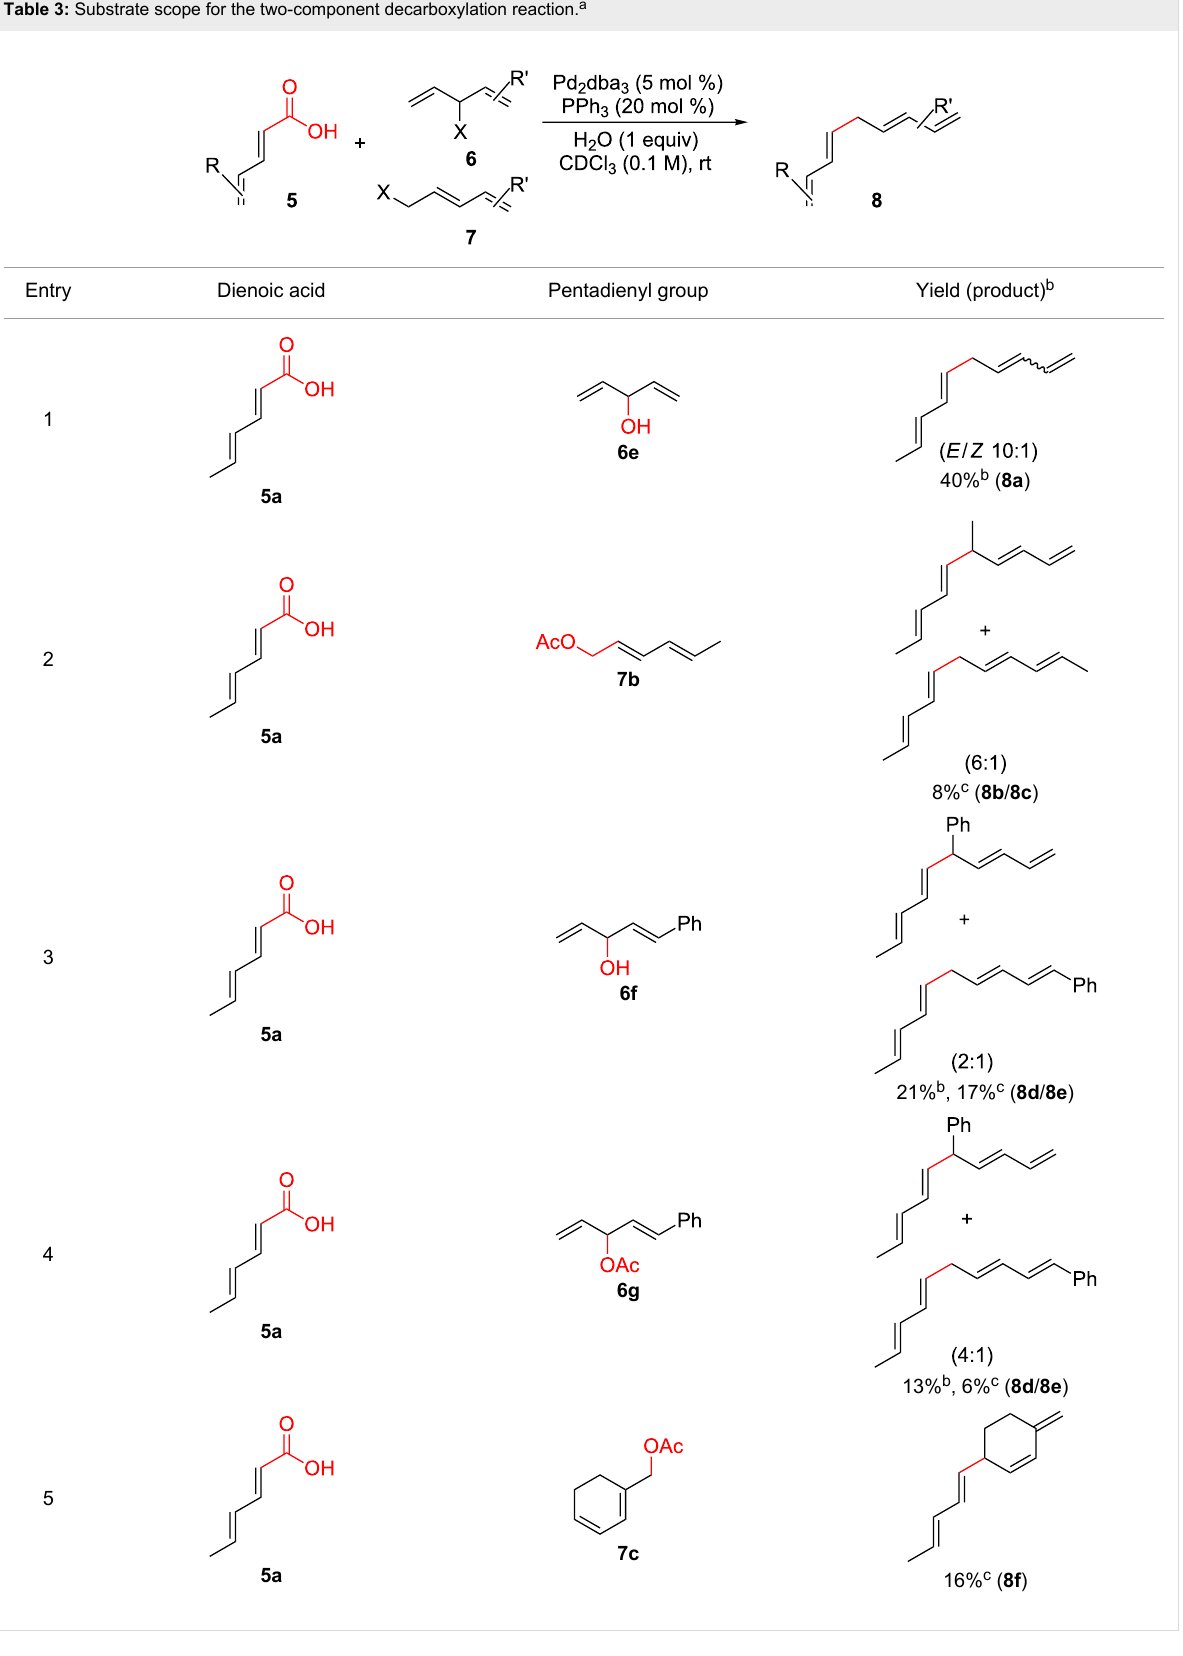
Table 3: Substrate scope for the two-component decarboxylation reaction.